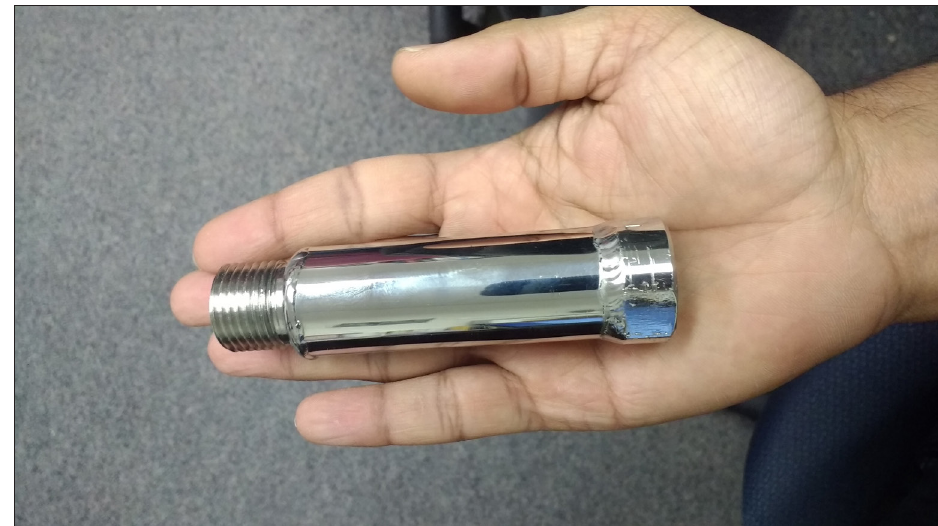
Figure 3: An NLP water “conditioner” that claimed to soften water without any treatment chemicals did not perform as advertised in a battery of laboratory tests conducted by our